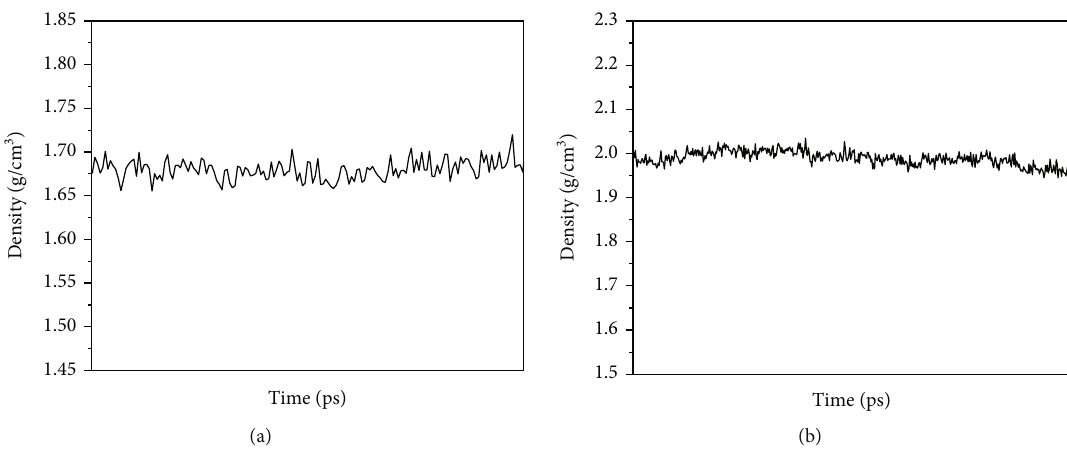
Figure 3: MD simulation of the fi nal 500ps PVDF (a) and BT20/PVDF (b) density based on the initial